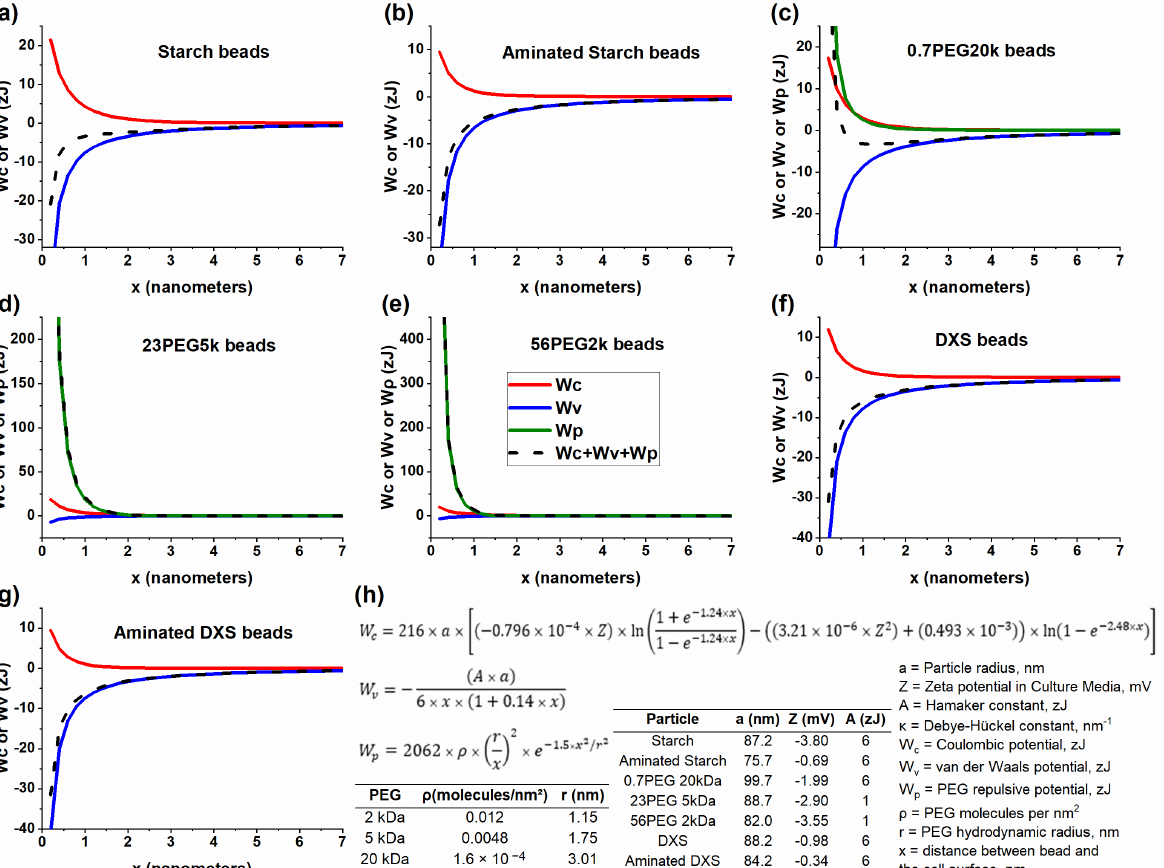
Figure 4. DLVO analysis of adsorption of the seven bead types to the surface of CHO cells in mon- olayer. ( a – g ) Potential energy diagrams, ordinate in zJ (10 – 21 Joules). Dashed lines represent total potential. Note changes in ordinate scales. ( h ) Numerical versions of the potential energy formulae and values and definitions of independent variables for each combination. Values of a and Z are from Table 1. The repulsion term W p only applies to PEGylated beads. See DLVO analysis (Section 2.7) for